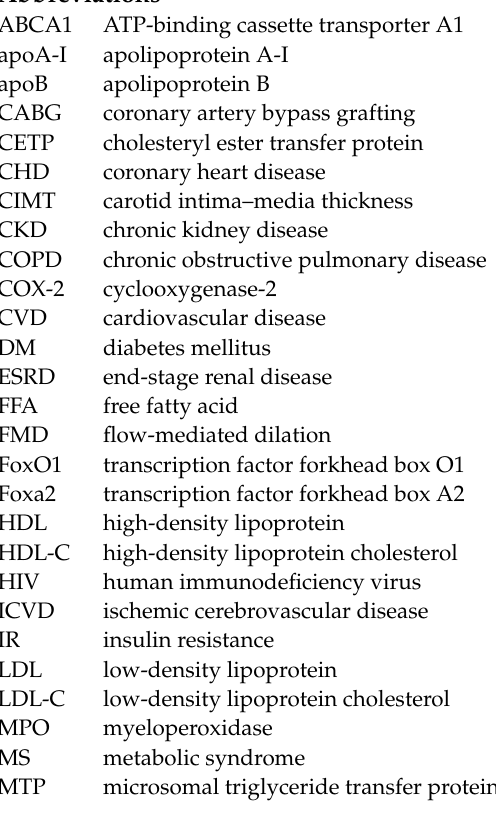
Table 4. The role of nitrated lipoproteins in the pathogenesis of cardiovascular disease—perspectives for future research. Research Question Is there a relationship between the concentration of nitrated lipoproteins and parameters of glycemic control in patients with diabetes? Is there a relationship between the concentration of nitrated lipoproteins and the systemic parameters of oxidative stress in patients with diabetes? Is there a relationship between the concentration of nitrated lipoproteins and the characteristics of myocardial systolic and/or diastolic dysfunction in patients with diabetes? Is there a relationship between the concentration of nitrated lipoproteins and the characteristics of subclinical dysfunction of the cardiovascular system measured with parameters such as flow-mediated dilation, intima–media thickness, pulse-wave velocity, ankle-brachial index, and toe-brachial index in patients with diabetes? Is there a relationship between the concentration of nitrated lipoproteins and anthropometric parameters (body mass index, waist circumference, waist–hip ratio, and body composition analysis results) in patients with diabetes? Can the concentration of nitrated lipoproteins be a useful marker of the risk of developing CVD and the risk of cardiovascular events in a prospective observation, and is the concentration of nitrated lipoproteins in this range a parameter independent of the concentration of nitrotyrosine and myeloperoxidase